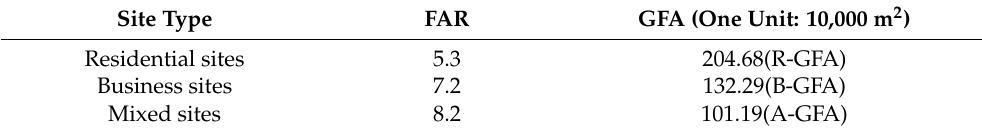
Table 18. Maximum development values for control.